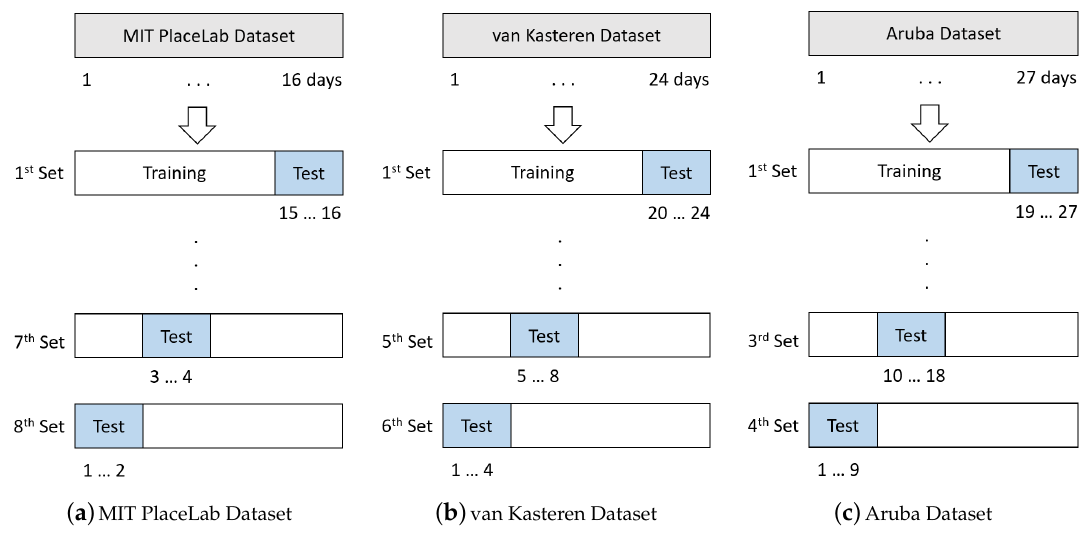
Figure 3. Evaluation method: ( a ) Leave-two-days-out cross-validation, ( b ) Leave-four-days-out cross-validation and ( c ) Leave-nine-days-out